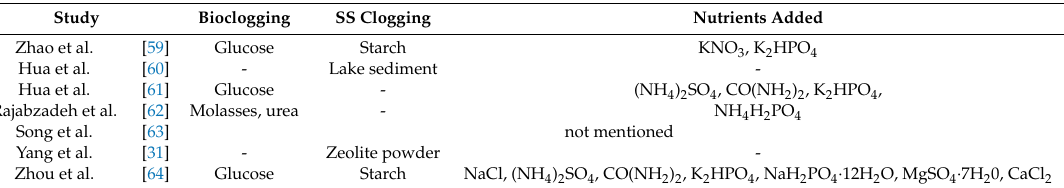
Table 3. Mixtures of synthetic wastewater used for